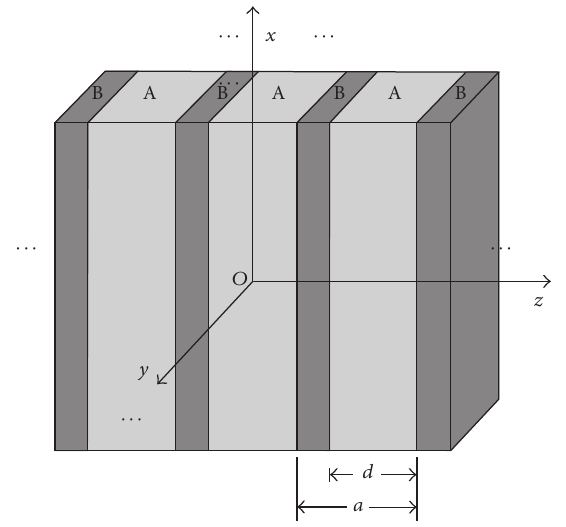
Figure 1: Scheme of the binary